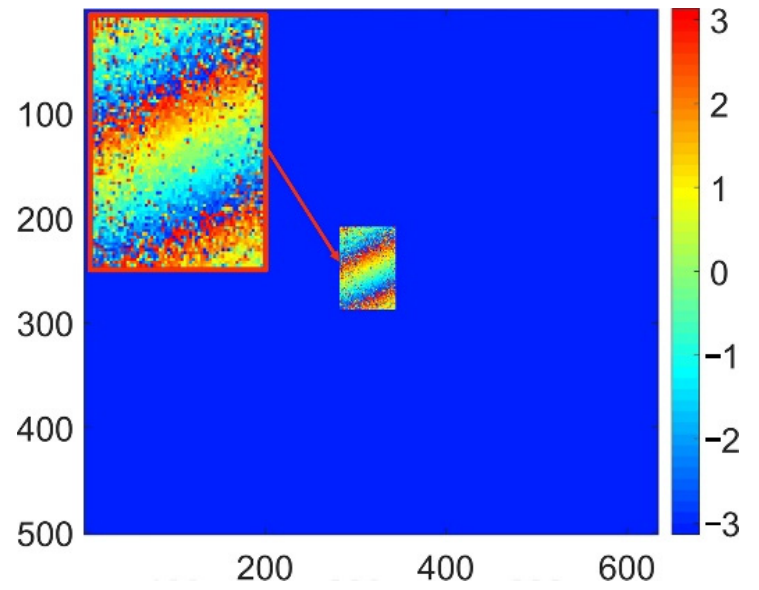
Figure 4. Cross-power spectrum matrix based on PSD screening.